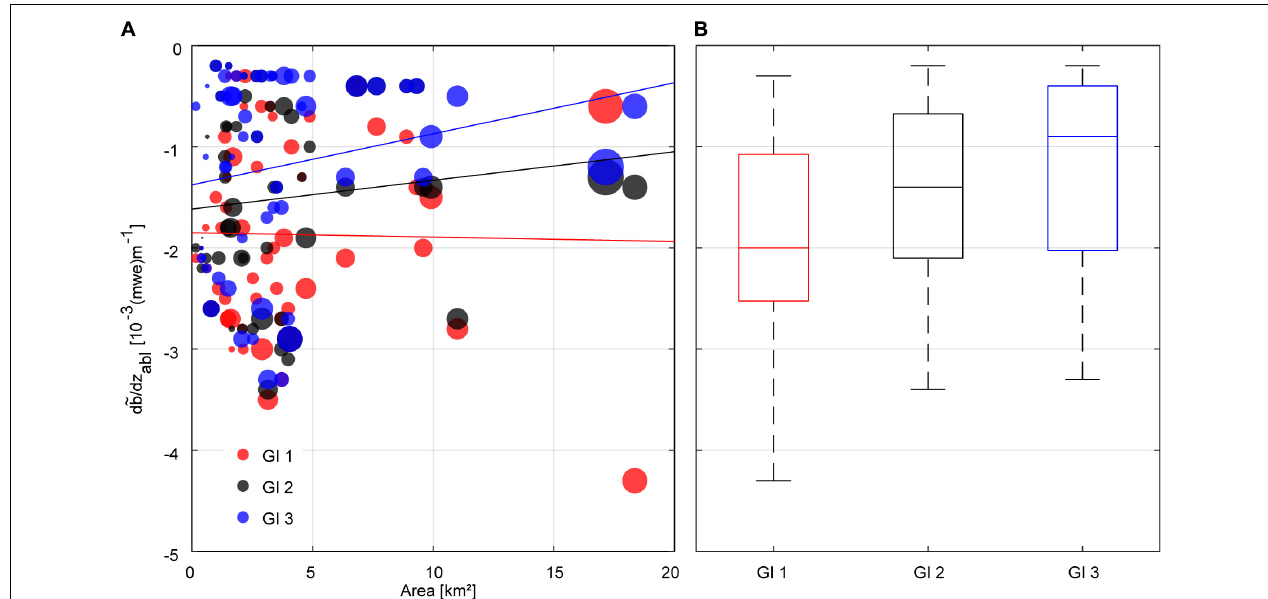
FIGURE 3 | (A) Calibrated glacier-specific apparent mass balance gradients ( d ˜ b / dz abl ) for the three glacier inventories. The size of the dots corresponds to the number of available ice thickness measurements. (B) The boxplots present the statistical distribution of the calibrated apparent mass balance gradients for the ablation area ( d ˜ b / dz abl ) and the three glacier inventories. The blue box shows the interquartile range between the 25 th and the 75 th percentiles. The dash in the box notes the median. The whiskers encompass all data within 1.5 times the interquartile range.